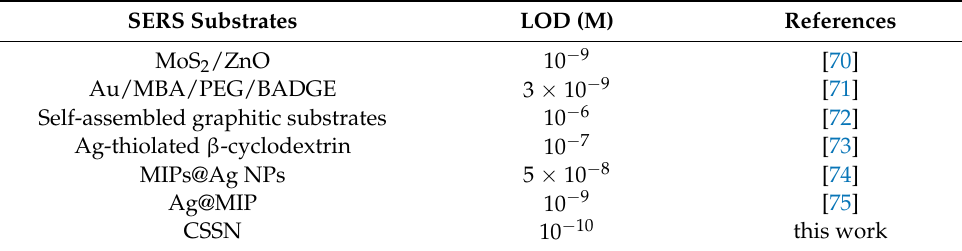
Figure 6. SERRS spectra of BPA azo products (from 10 − 10 to 10 − 4 M) adsorbed on CSSN NCs ( a ). The relationship between the SERRS intensity and concentrations of BPA azo products ( b ). Table 1. Comparison of the SERS sensitivity of different SERS substrates to BPA.